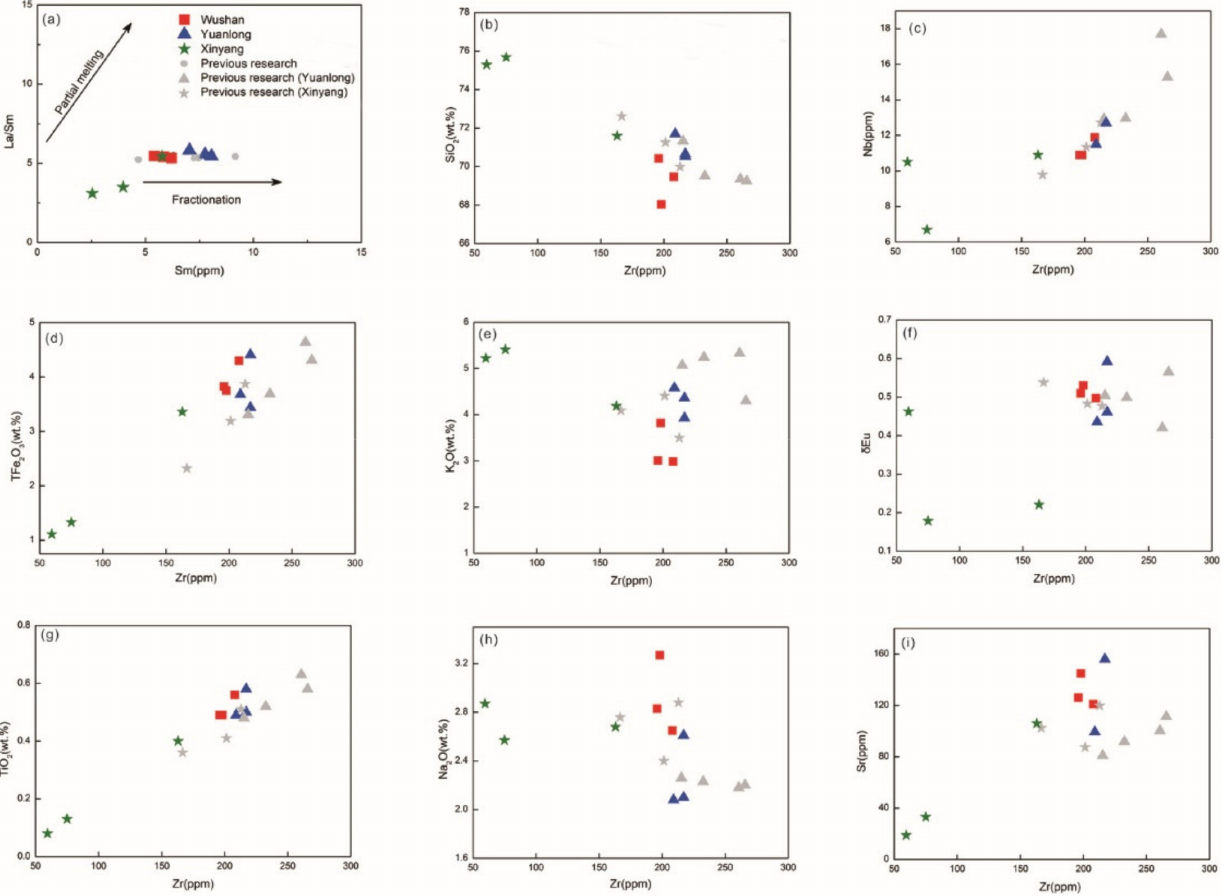
Figure 12. ( a ) La/Sm–Sm diagram illustrating trends in the partial melting and fractional crystalliza- tion of the studied granitic rocks from the western margin of the NQT. Harker diagrams ( b – i ) for major and selected trace elements for the studied samples. Data source for the previous research: